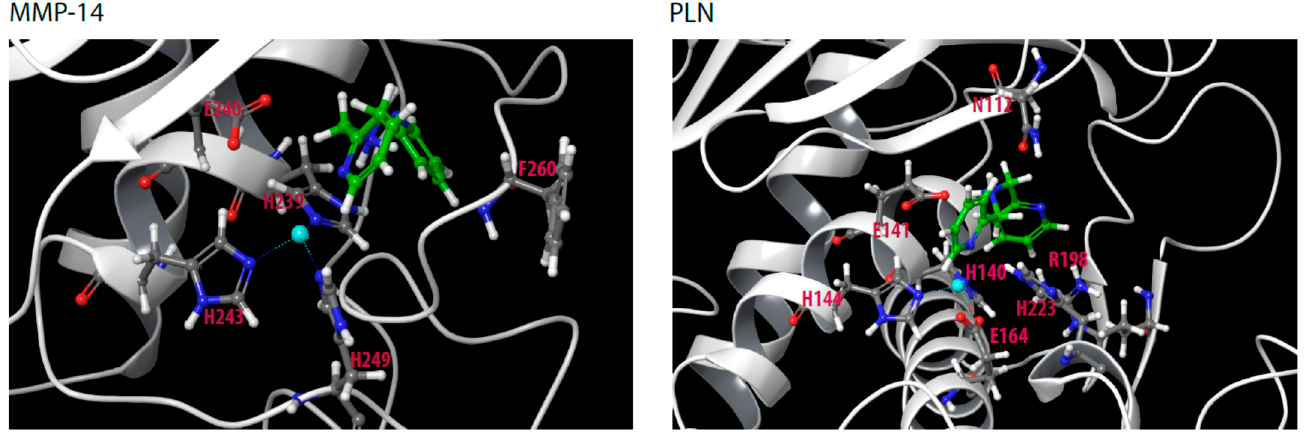
Figure 7. Docking of DPA into the catalytic site of MMP-14 and PLN. Some of the most important amino acids for binding DPA are shown. Color coding as in Figure amino acids for binding DPA are shown. Color coding as in Figure 5.